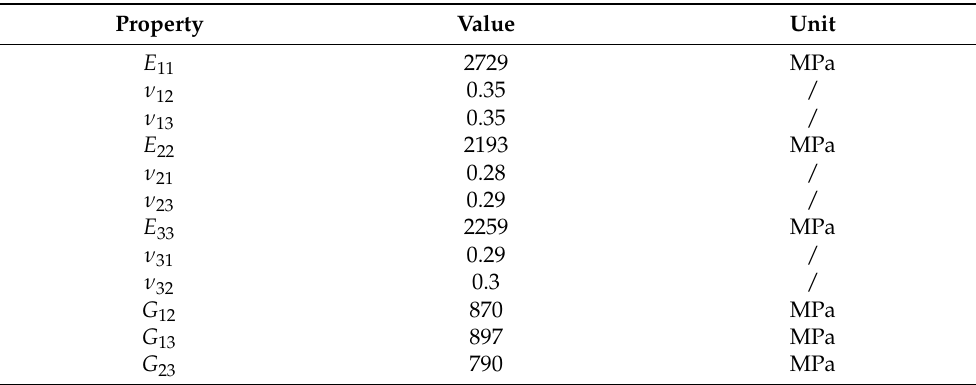
Table 3. Homogenized elastic